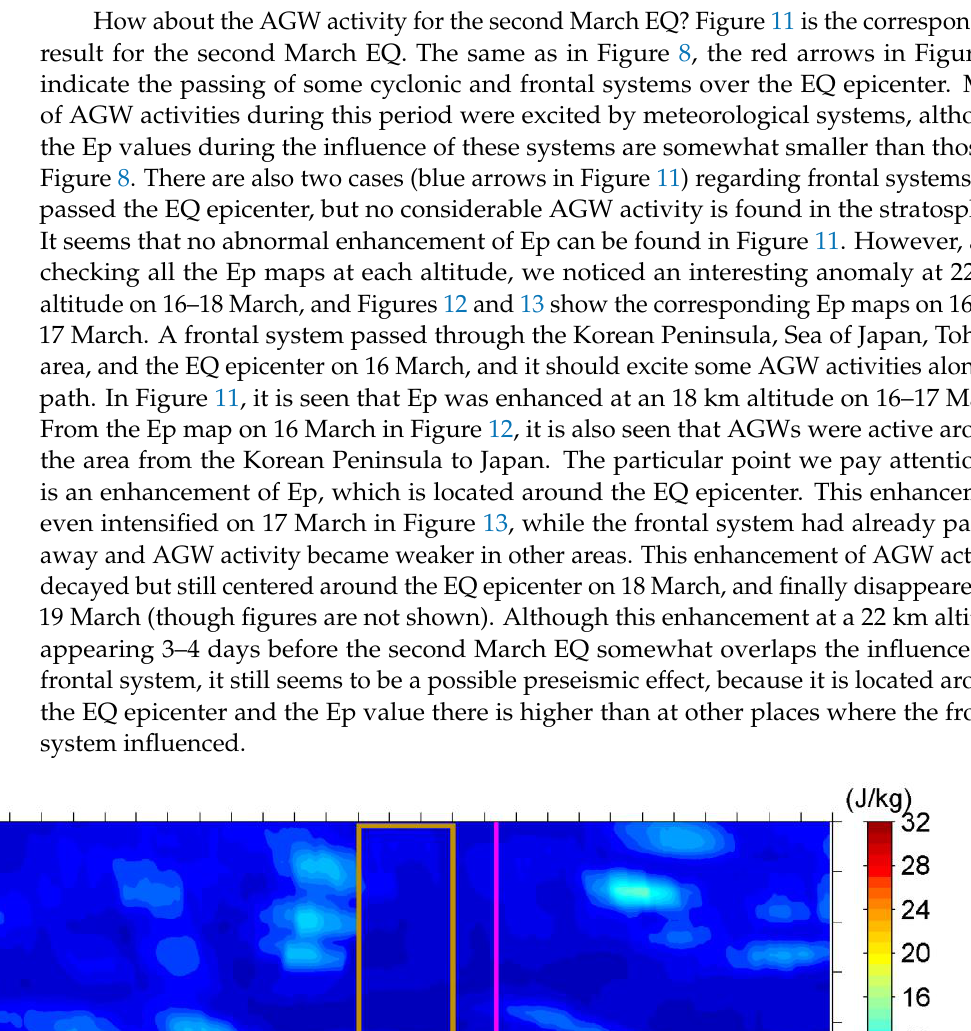
Figure 12. Same as in Figure 9, but for the second March EQ at a specific altitude of 22 km on 16 March. The color scaling is also different from that in Figure 9.